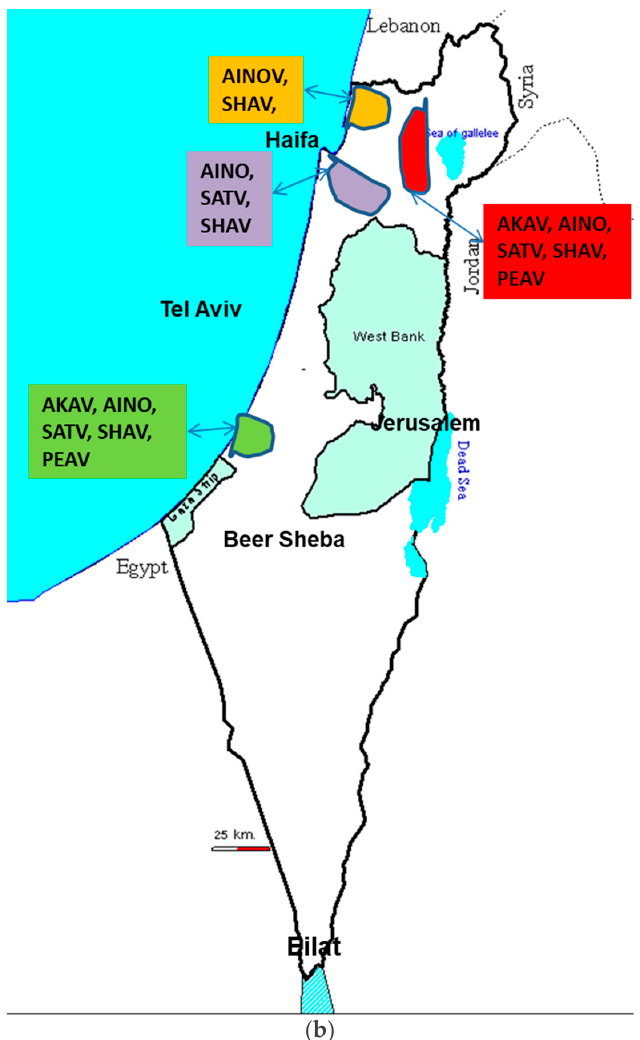
Figure 4. These figures show the anamnestic Simbu viruses reactive sera of adult milking cows born before 2010 ( a ) and heifers seroconverted in 2013 summer-early autumn ( b ). AKA, AINO, PEA, SAT, SHAV, SHU: Akabane, Aino, Peaton, Satuperi, Shamunda, Shuni, viruses. SHAV, SHU: Akabane, Aino, Peaton, Satuperi, Shamunda, Shuni,